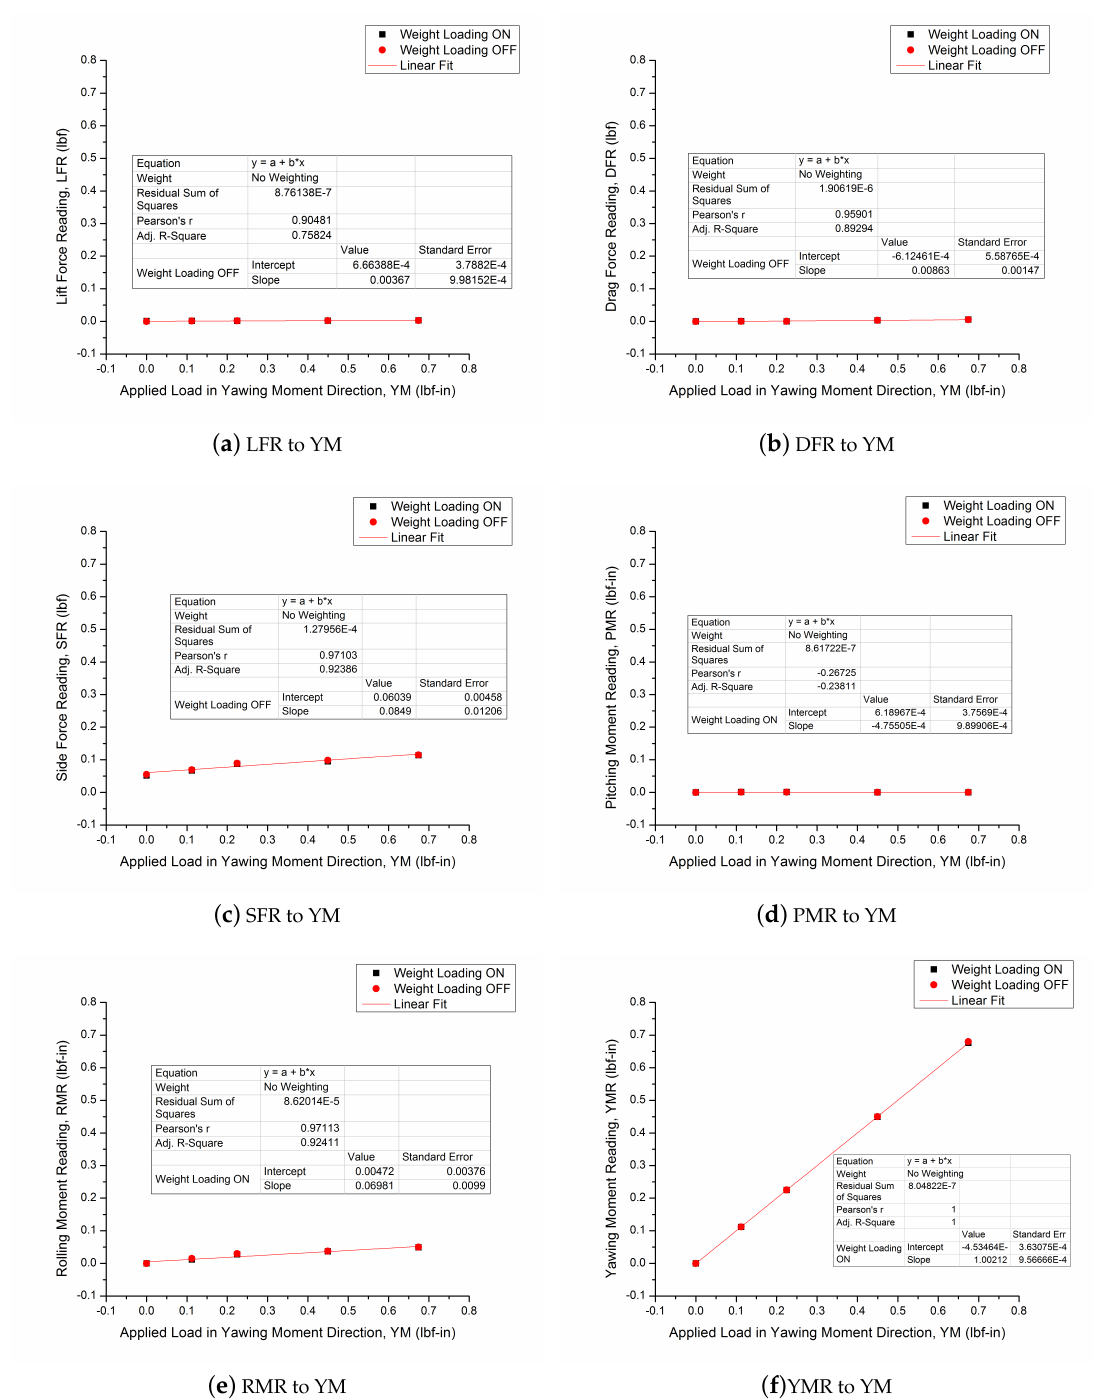
Figure A6. Experimentally obtained wind tunnel pyramidal balance interactions upon applied load in yawing moment